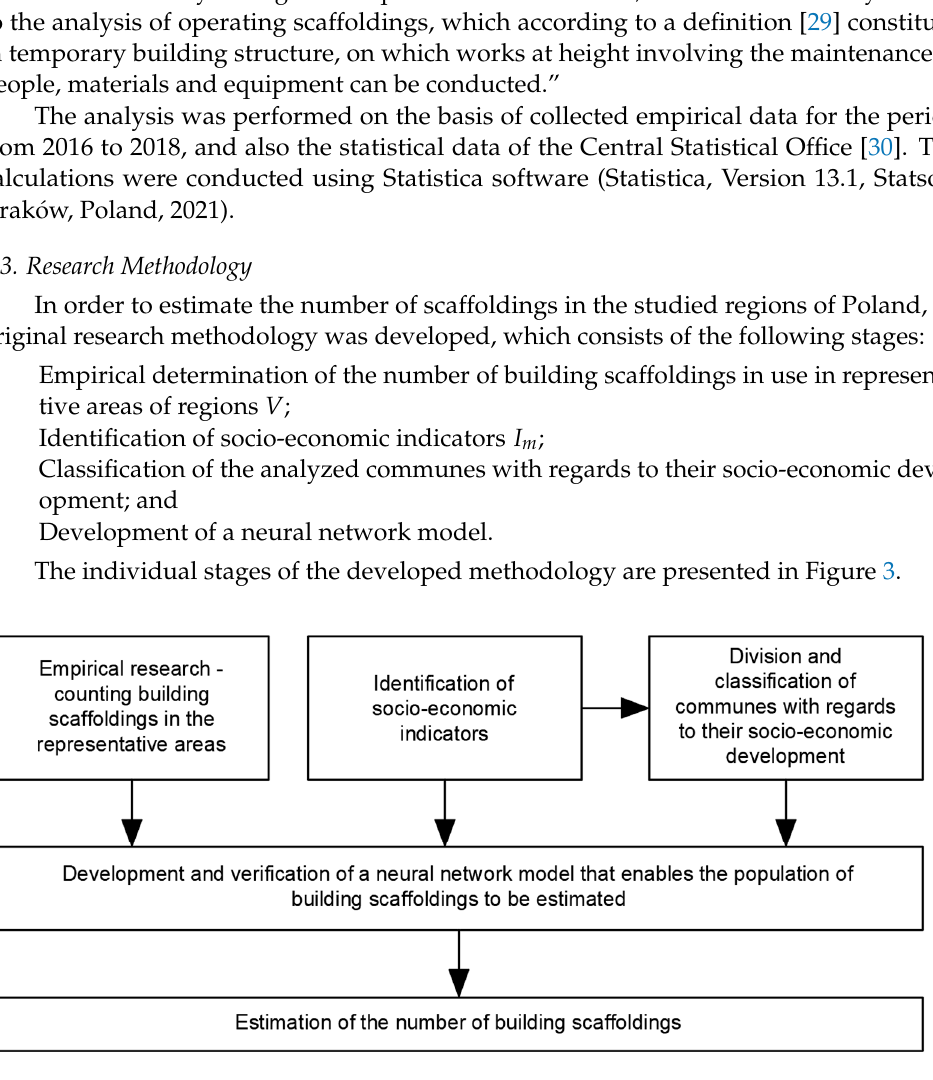
Figure 3. Original methodology for estimating the number of building scaffoldings.